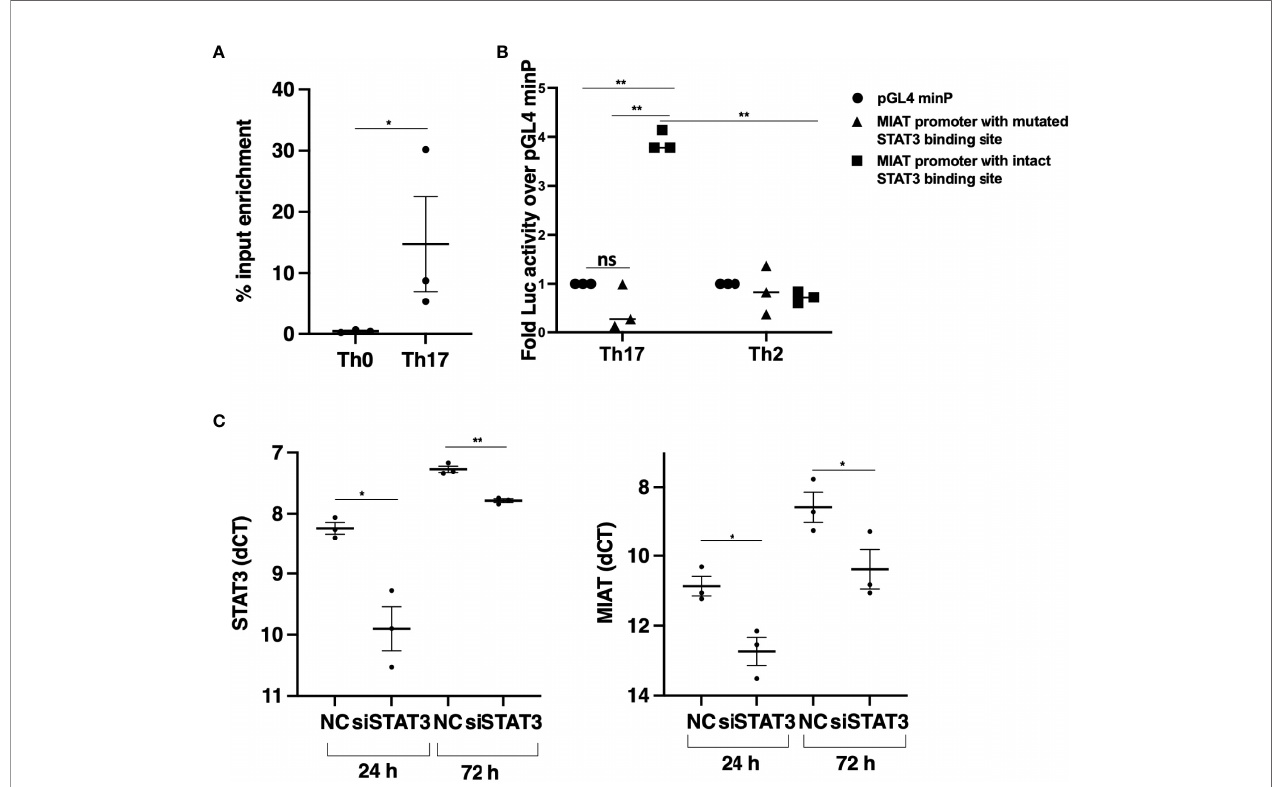
FIGURE 2 | STAT3 Binds at MIAT Promoter and Upregulates its Expression in Th17 Cells. (A) TaqMan-qPCR of MIAT promoter performed on STAT3 ChIP of 0.5-h Th17 and Th0 cells. The percent input was used to calculate the enrichment, and error bars represent SEM. *, p < 0.05. (B) The promoter region ( – 1500 to +250 base-pair relative to TSS) was cloned upstream of the fi re fl y luciferase coding region. The vector containing the MIAT promoter region or empty vector (pGL4 minP) was nucleofected into Th17 or Th2 cells, and the fi re fl y luciferase activity was measured. The data were normalized to renilla luciferase for transfection ef fi ciency and presented with respect to the control vector. For details, see the method section and Figure S2B for schematics. Error bars represent SEM of three experiments. Statistical analysis was performed by paired two-tailed Student ’ s t-test. *, p < 0.05. (C) STAT3 (left) and MIAT (right) expression in STAT3-silenced Th17 cells by TaqMan qPCR analysis. The STAT3 siRNAs (siSTAT3) were used to knockdown STAT3 in three individual donors before Th17 polarization for 24 and 72 h. Non- targeting control siRNA (siNC) was used as control. Each dot represents an individual donor. Students ’ paired two-tailed t-test was used to determine the signi fi cance. *p <0.05; **p <0.01. In all the panels, the experiments were performed on three pools of CD4 + T cells, where each pool contained cells puri fi ed from umbilical cord blood collected from 3-5